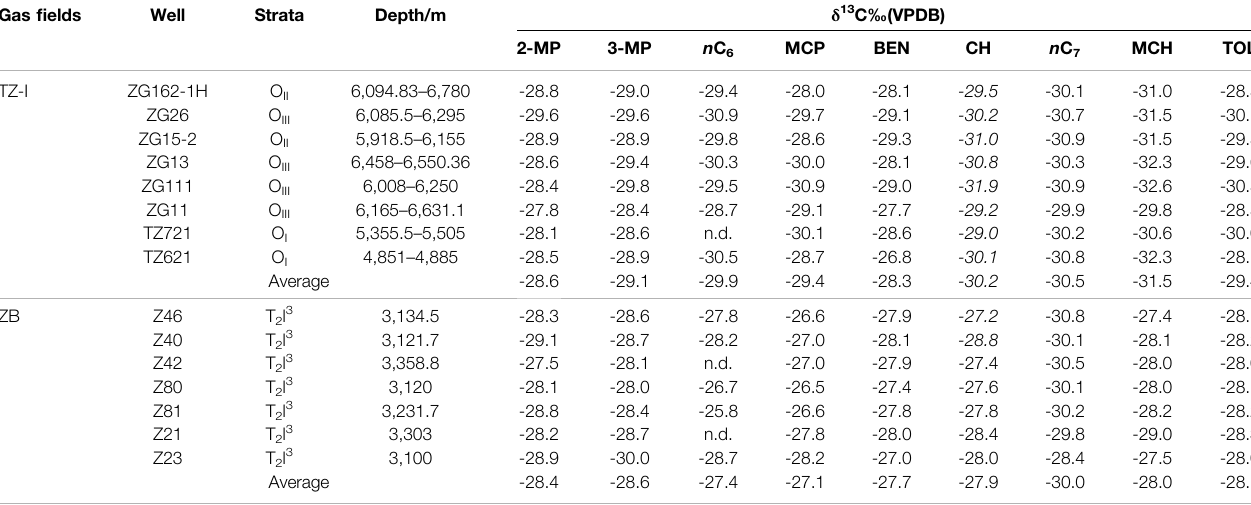
TABLE 3 | Individual light hydrocarbons carbon isotope of fi fteen gases from the TZ-I and ZB gas fi elds. Gas fi elds Well